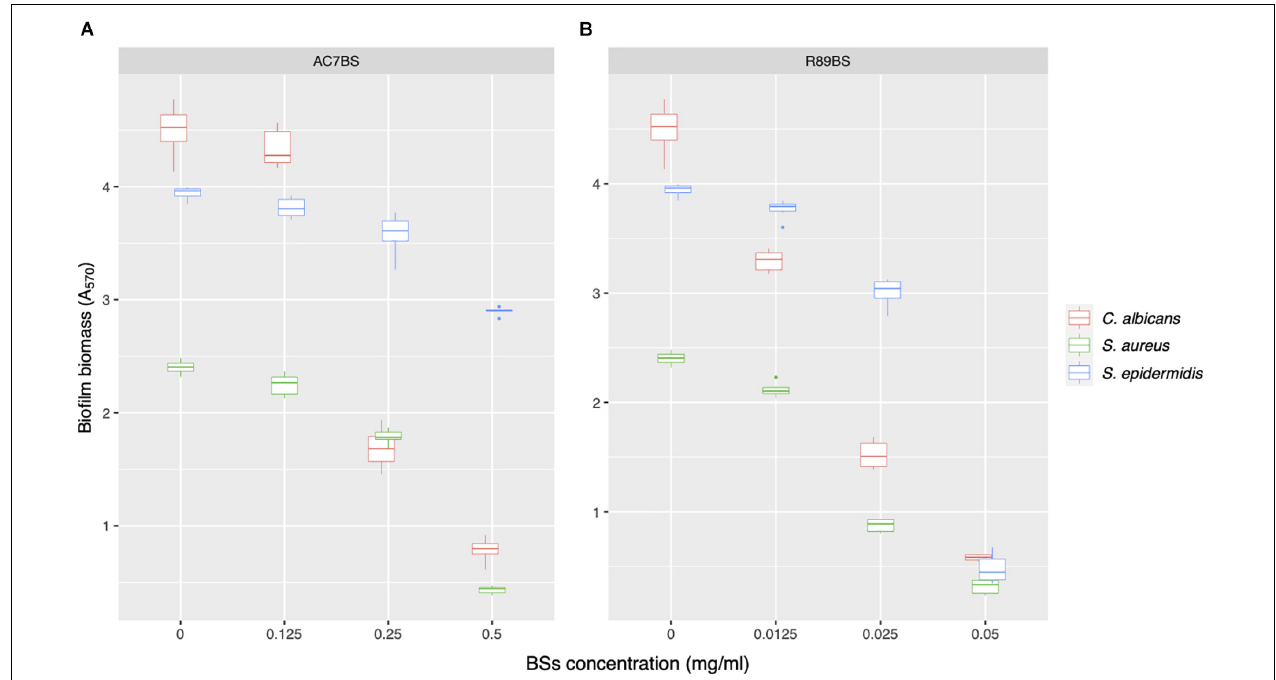
FIGURE 3 | Activity of BSs in soluble form on C. albicans , S. aureus , and S. epidermidis biofilm formation. The anti-biofilm activity of AC7BS (A) and R89BS (B) was evaluated in co-incubation conditions by the determination of biofilm